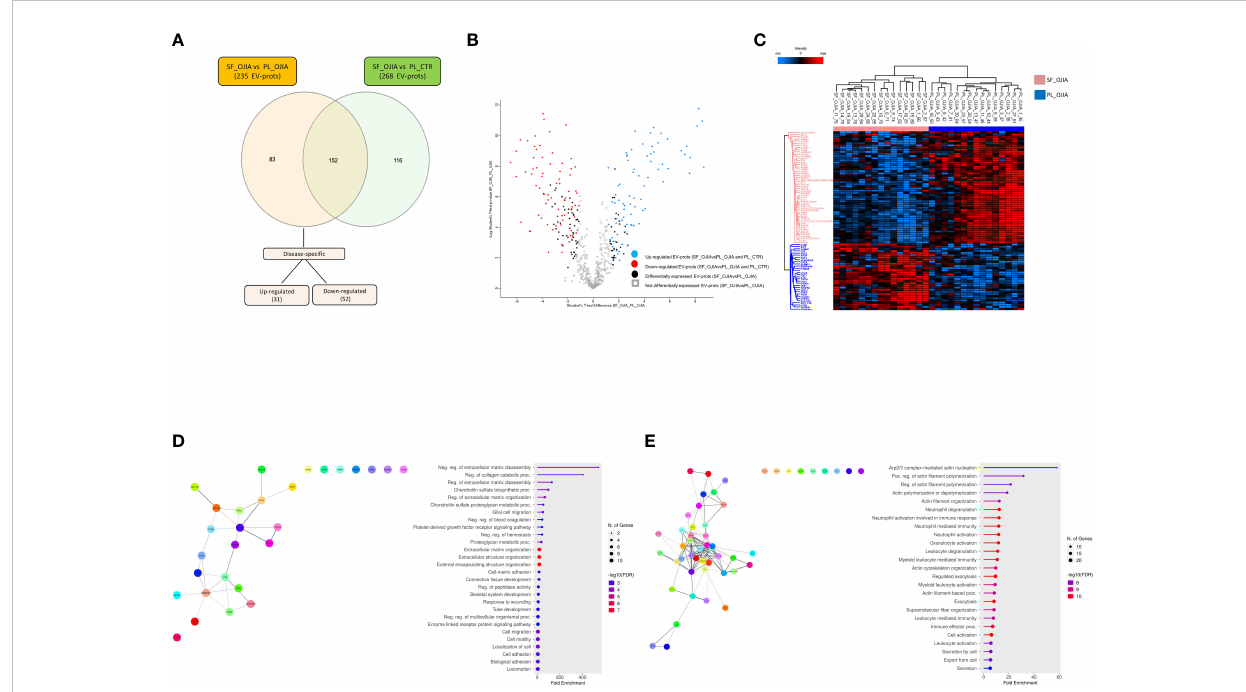
FIGURE 3 Speci fi c EV-prot expression pattern differences between paired SF and PL specimens from new-onset OJIA patients. EV-prots isolated from paired SF and PL samples of new-onset OJIA patients and PL of CTR children were pro fi led, and those exclusively differentially expressed in the comparison SF_OJIA vs PL_OJIA respect to SF_OJIA vs PL_CTR were identi fi ed and subjected to network and functional enrichment analyses. (A) Venn diagram shows the number of common and exclusive differentially expressed EV-prots detectable between the comparison of SF-OJIA vs PL-OJIA and SF-OJIA vs PL-CTR. Each comparison is depicted by a distinct color. Up- and downregulated exclusively differentially expressed EV- prots are indicated. The signi fi cance of the overlapping was estimated with hypergeometric statistics. (B) Volcano plot shows the changes in protein expression levels between the two comparisons. Signi fi cance ( – log10 of p value) is plotted on the y axis versus fold-change (log2) on the x axis. On the left are shown EV-prots signi fi cantly downregulated and on the right those signi fi cantly up-regulated in OJIA_SF samples with respect to PL_OJIA. (C) Heat-map representation shows unsupervised hierarchical clustering analysis of EV-prots speci fi cally differentially expressed in paired SF_OJIA vs PL_OJIA groups of samples. EV-prot expression levels were z-scored and log2 transformed and are indicated by a two-color scale ranging from blue (lowest values) to red (highest values) reported in the horizontal bar at the top of the fi gure. Each column corresponds to a sample (indicated on the top side) and each row represents a differentially expressed protein derived from the comparison. The pink and blue bars above the columns distinguish the SF and PL groups. Dendrogram reporting the results of the unsupervised hierarchical clustering is displayed at the top of the plot. Differences in EV-prot expression levels were considered statistically signi fi cant when s0 = 1 and FDR = 0.01. The optimal association between two main clusters of EV-prots (indicated by the pink and blue bar on the left side) identi fi ed by the unsupervised hierarchical method and the SF and PL groups of samples is shown (D, E) Network and pathway enrichment analyses were carried out on the subset of EV-prots exclusively up- (D) and down- (E) regulated in paired SF_OJIA vs PL_OJIA samples. Functional interaction networks among EV-prots were built using STRINGApp and are displayed graphically as nodes (EV-prots) and edges (predicted protein – protein interactions). Colored nodes indicate query EV- prots. Filled nodes indicate some 3D structure known or predicted. Line thickness indicates the strength of data support. Medium con fi dence of 0.4 was set up as the minimum required con fi dence score, and a PPI enrichment FDR value < 0.05 was considered signi fi cant. Functional enrichment analysis for GO biological processes were conducted by ShinyGO, and enriched pathways were considered signi fi cant if FDR value ≤ 0.05. The graph shows the top enriched terms. EV-prots might appear in more than one term depending on their function. The GO term name is reported on the y- axis, fold enrichment for each term is indicated on the x-axis. GO terms are listed by decreasing fold enrichment